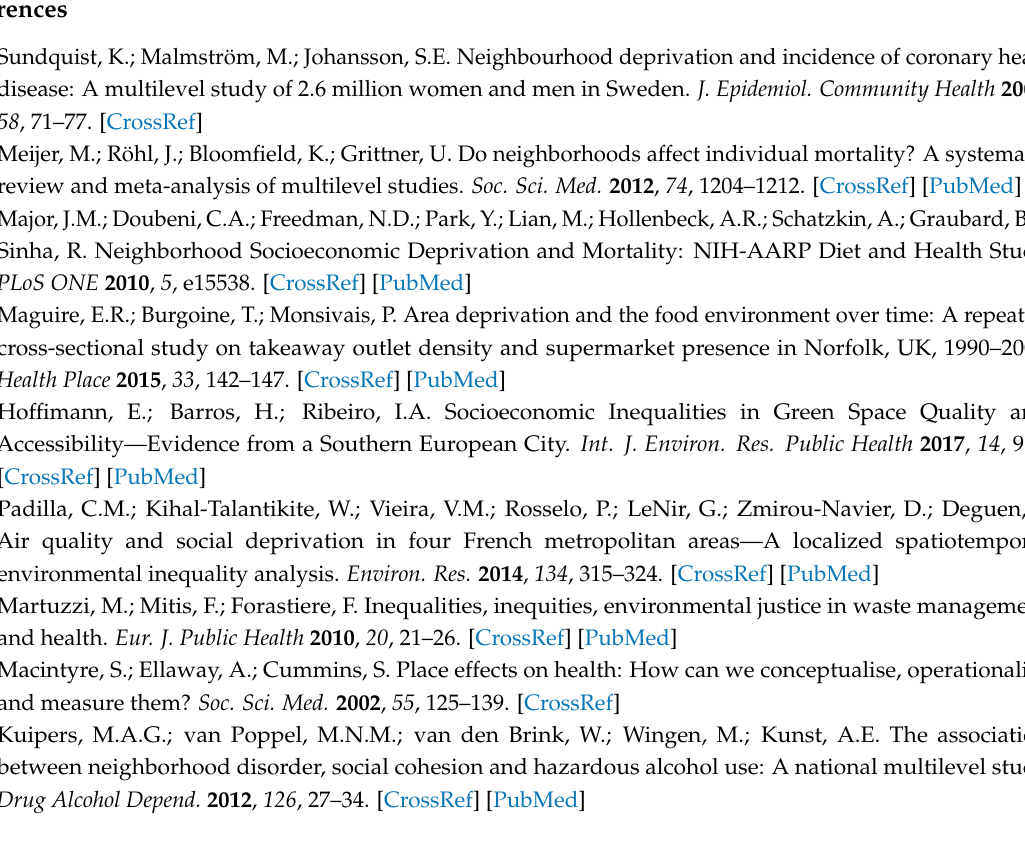
Table S1: Characteristics of the studies included in the scoping